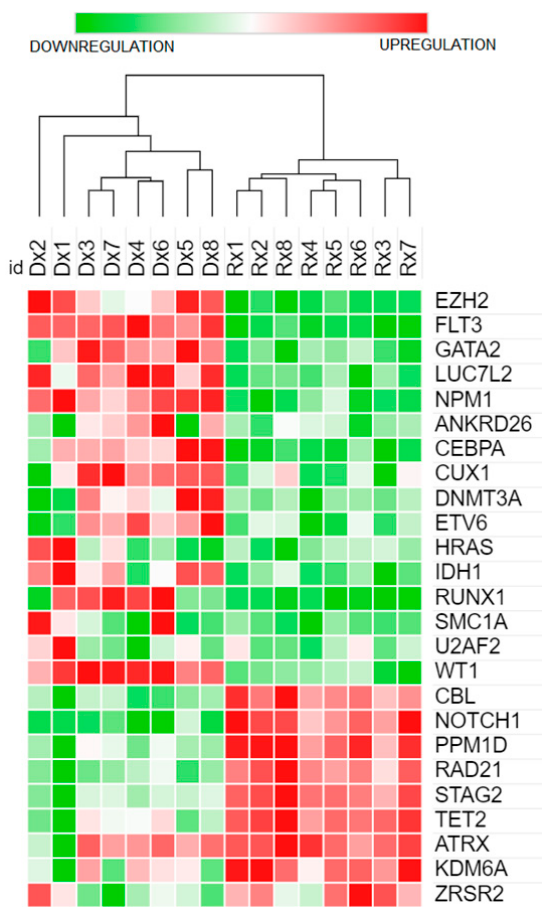
Figure 4. Heatmap of genes with variants during disease presentation and after attainment of CR1/CR2.